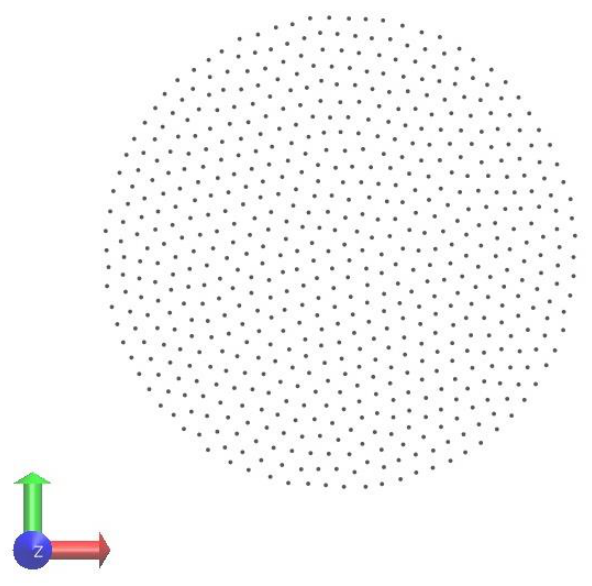
Figure 1. The initial configuration of the system at Г* 0 = 300.